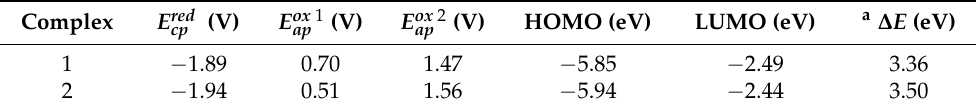
Table 3. Selected electrochemical data extracted from the CVs of complexes 1 and 2 . Complex E red cp (V) E ox 1 ap (V) E ox 2 ap (V) HOMO (eV) LUMO (eV) a ∆ E